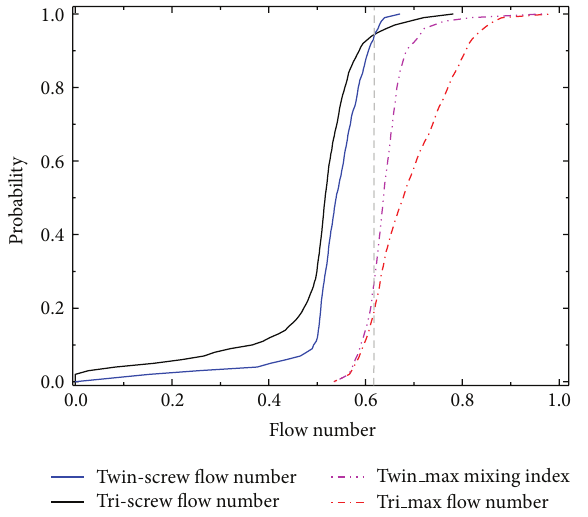
Figure 7: Comparisons of the probability of flow number in the two types of extruders.